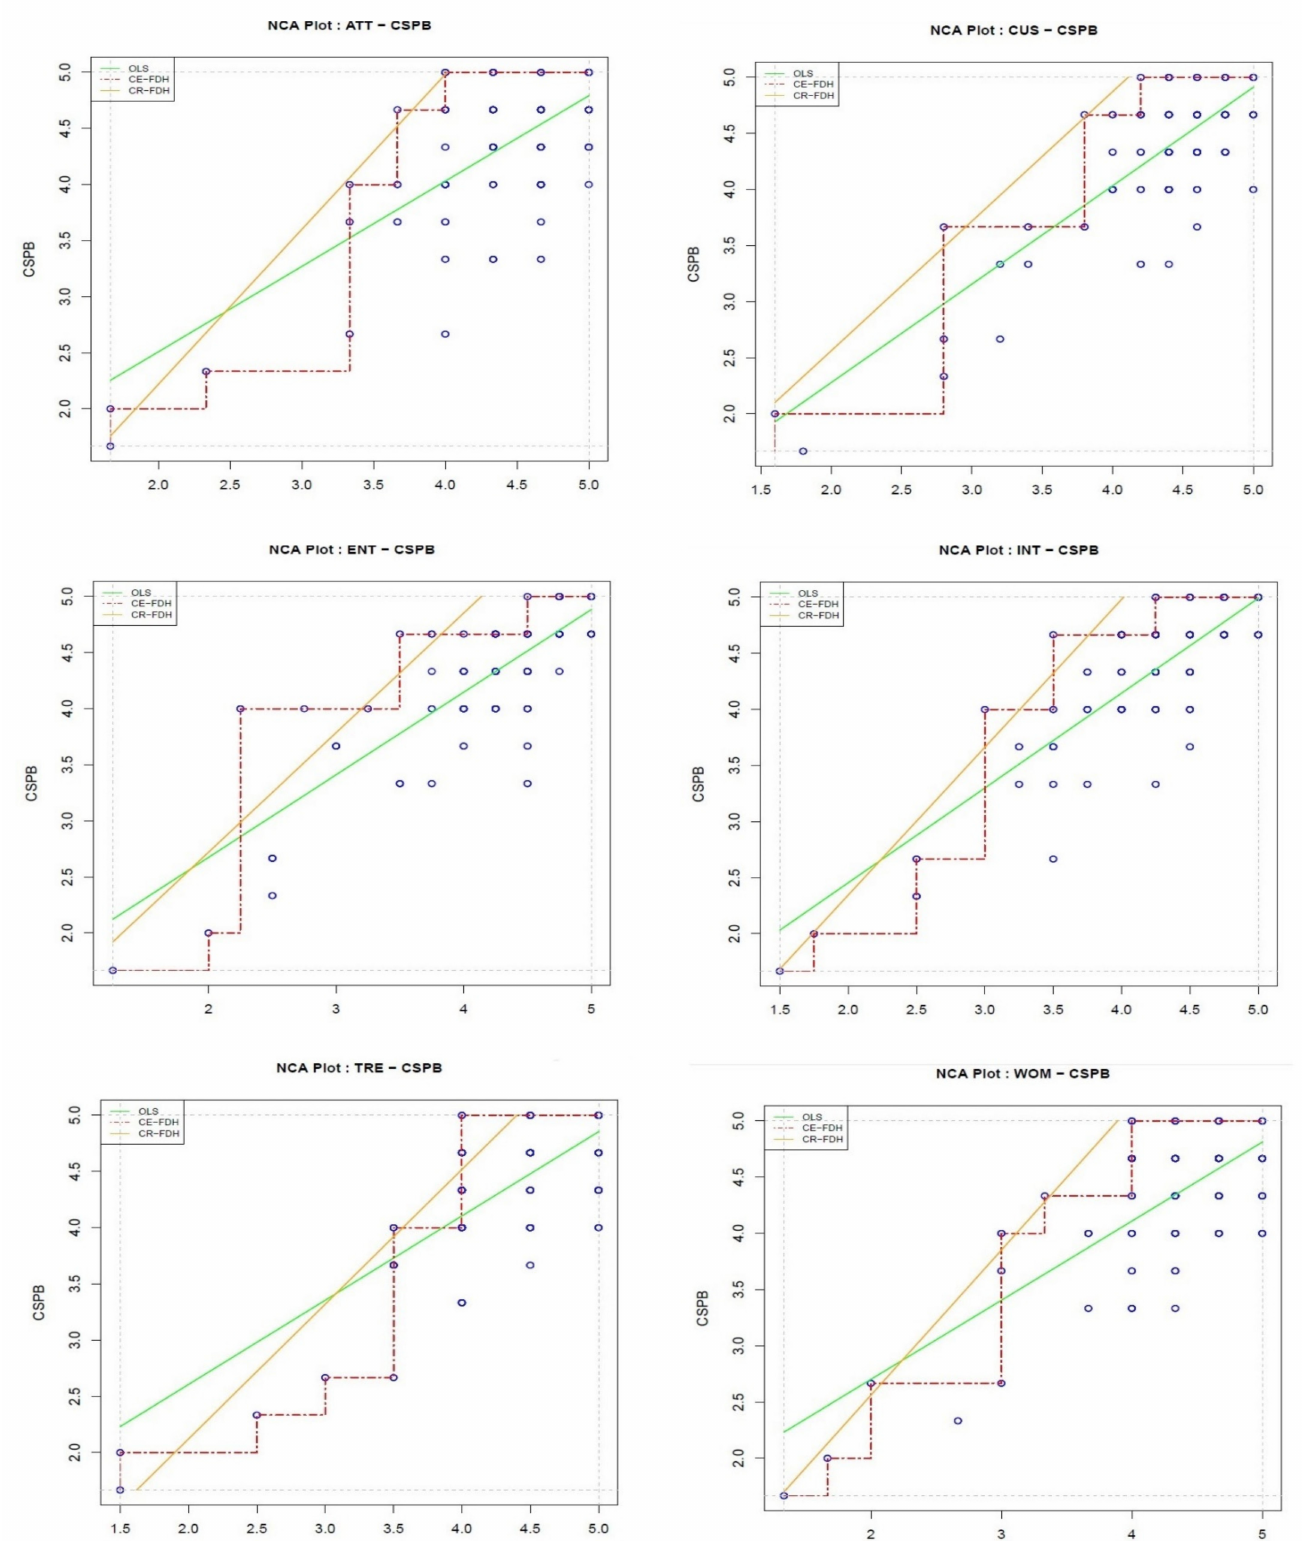
Figure 5. Scatter plots of Necessary Condition Analysis